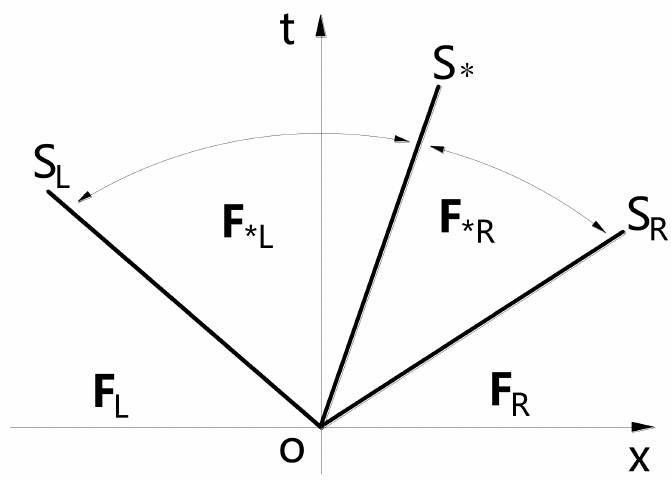
Figure 3. Structure of the Harten–Lax–van Leer–contact (HLLC) approximated Riemann